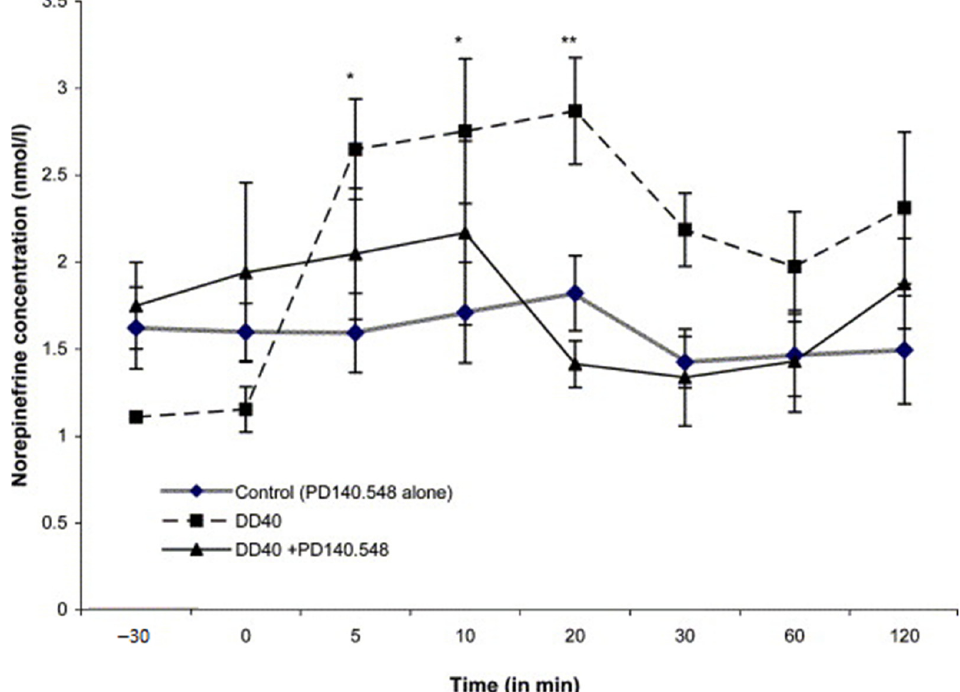
Figure 9. Comparative analysis of PD140.548 (ICV infusion) on changes in plasma norepinephrine concentrations before and after 5 min of DD40 episode in comparison to controls (100 µL of 0.9% NaCl, n = 6 ± SEM). Points that are significantly different from control are marked with askterisks [50]; * p < 0.05 and ** p < 0.01.